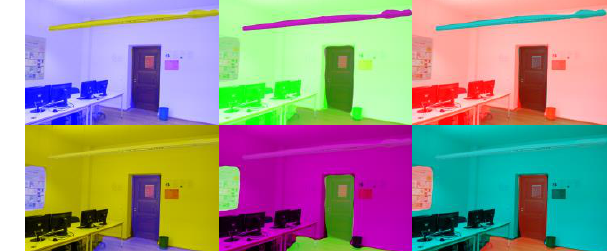
Figure 2. From the original image (left) derived ground truth image (right) with marked building parts in assigned colours Figure 4. Combined images as a replacement of one of the RGB containing unique IDs. channels. Left: Replacement of the Blue channel. Middle: replacement of the Green channel. Right: Replacement of the Red channel. Background value on the top is 255 and 0 on the